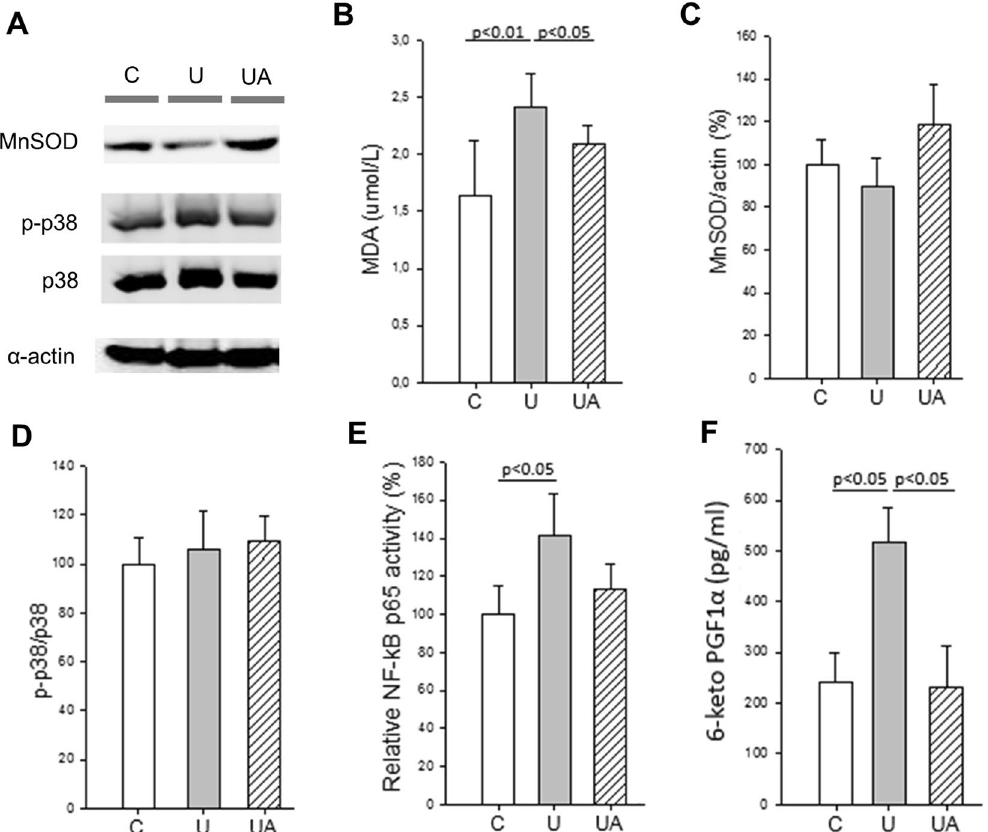
Figure 2. Allopurinol-treated mice are partially protected against hindlimb unloading-induced inflammation and oxidative stress. ( A ) Representative western blotting of soleus proteins (full-length blots are included in supplementary information. See Supplementary Figure 2). ( B ) Shows plasma MDA levels measured by HPLC. ( C and D ) show the densitometric analysis quantified by using relative expression in arbitrary units of MnSOD ( C ), and p-p38 ( D ). ( E and F ) Show NF- κ B p65 binding activity ( E ), and plasma 6-keto prostaglandin F1 α ( F ) Determined by ELISA. Actin was used as a loading control. Data are shown as mean ± SD. C (n = 4–7), U (n = 4–6), and UA (n =